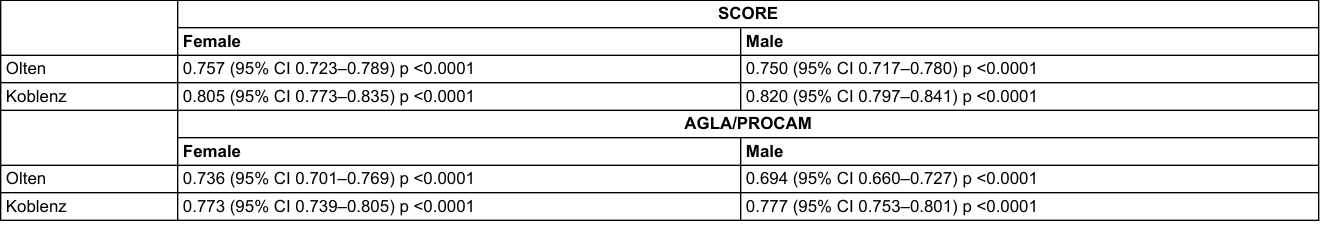
Table 7: Area under receiver operating curves by sex, SCORE/PROCAM and region for the detection of